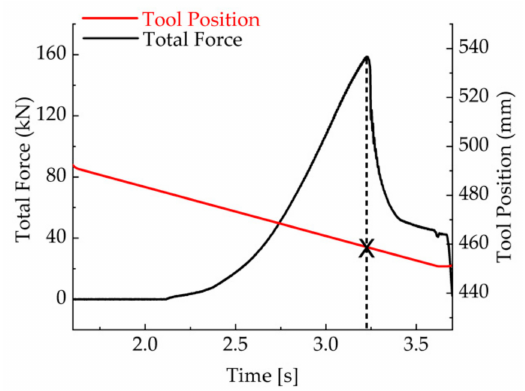
Figure 4. Detail of the force drop indicating the exact position where the depth position of the punch is located. The point of intersection indicates the maximum drawing depth.